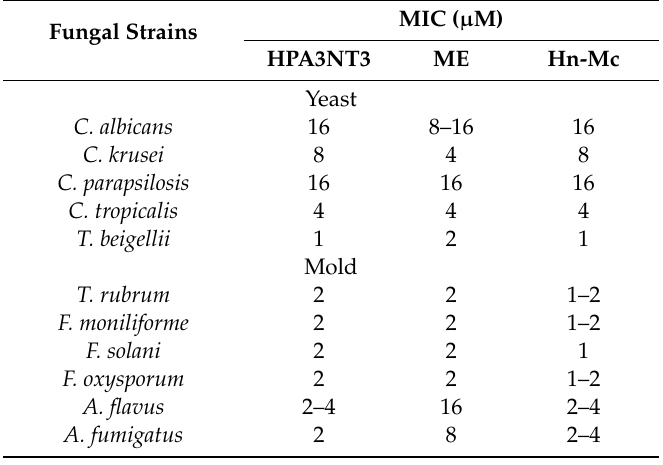
Table 1. Antifungal activity of peptides against fungal